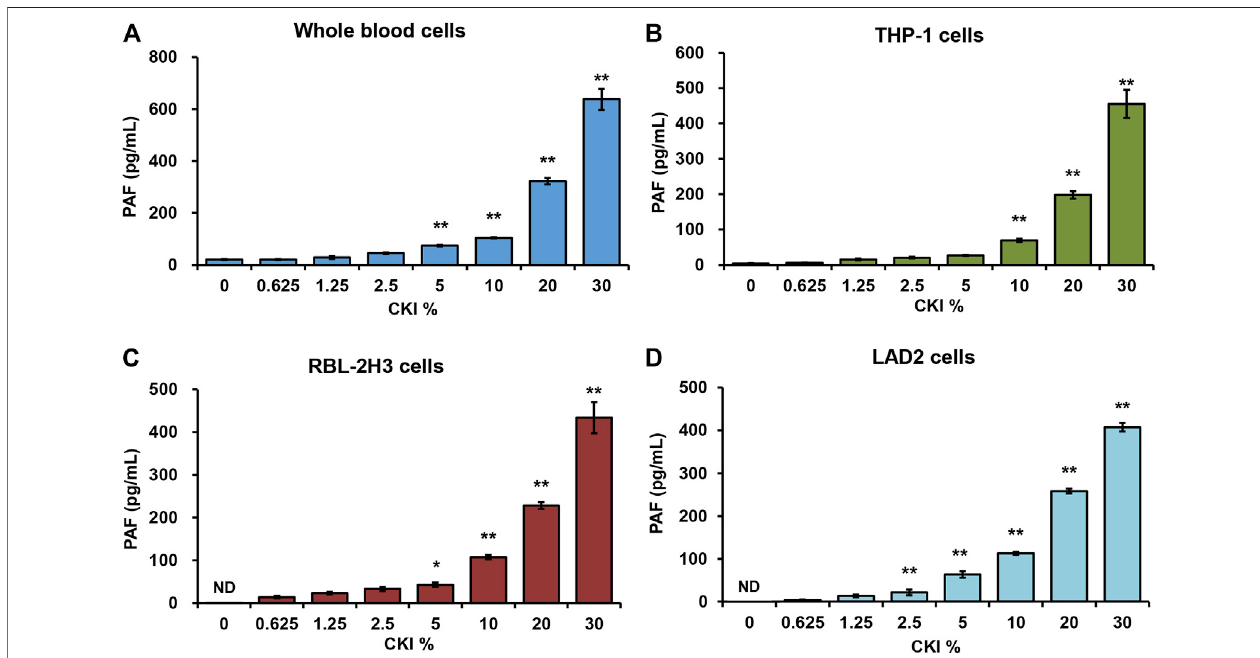
FIGURE5| CKIpromotesPAFproductionin (A) wholebloodcells (B) THP-1cells (C) RBL-2H3cellsand (D) LAD2cells.CellswereincubatedwithCKIat37 ° Cfor 1 h. The cell culture supernatant was collected and centrifuged (1,000 × g) at 4 ° C for 20 min. The supernatant was used for PAF assay by using commercial PAF ELISA kit. PAF concentration was calculated according to the standard curve. * p < 0.05 and ** p < 0.01 vs 0% CKI. CKI, Compound Kushen Injection; ND, not detected; PAF, platelet-activating factor.